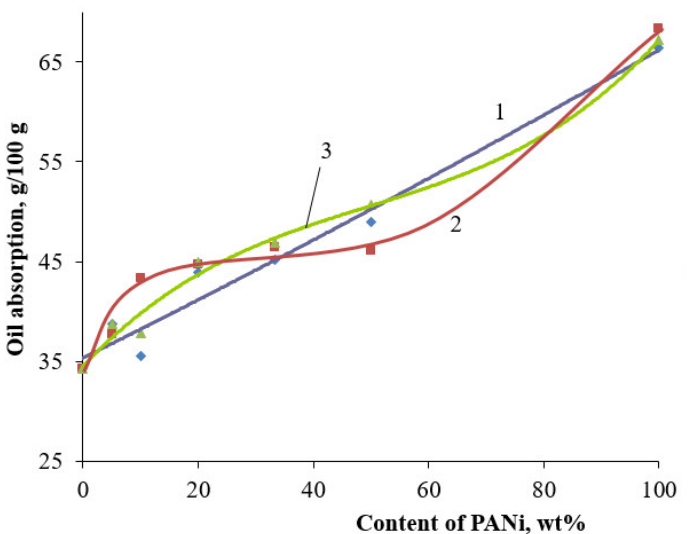
Figure 13. Dependence of oil absorption of core/shell pigments with a talcum core, from the content of PANi doped with various acids. Doping acid: (1)—H 2 SO 4 ; (2)—HCl; (3)—H 3 PO 4 .